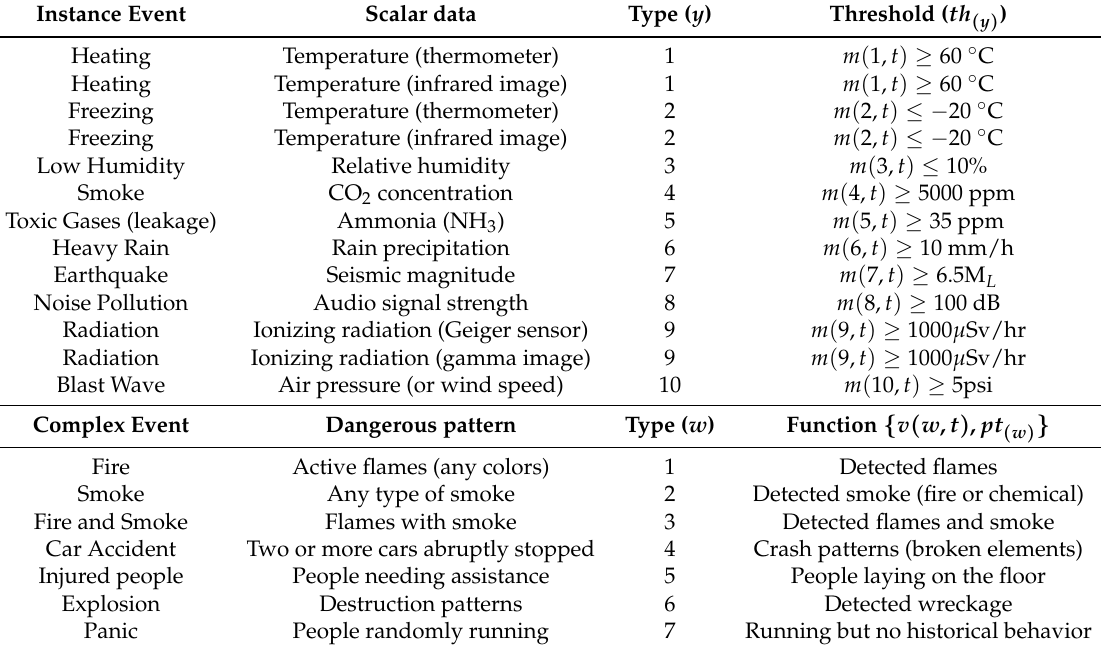
Table 1. Examples of instance and complex events when managing emergencies in urban